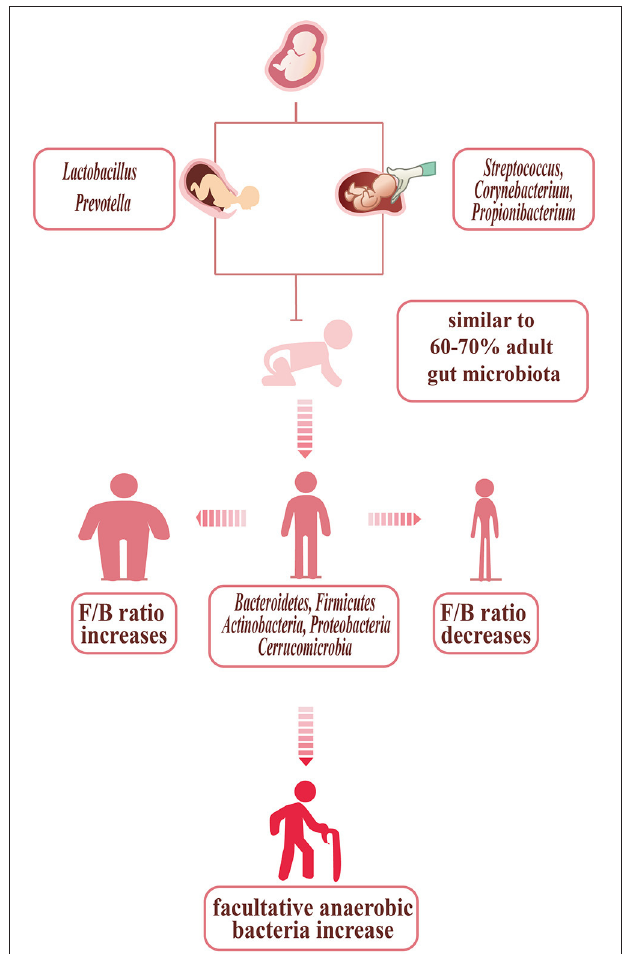
FIGURE 1 | Bacterial changes with age, delivery mode, and body shape. The infants’, born through vagina, are initially colonized by vaginal microorganisms— Lactobacillus and Prevotella. The infants’, born through cesarean section, are dominated by Streptococcus , Corynebacterium , and Propionibacterium , similar to the skin of humans. In children up to 3 years old, the gut microbiota is stable, with 60–70% similarity to the adult gut microbiota. The gut microbiota of adult with normal shape is mainly composed of five phyla: Bacteroidetes , Firmicutes , Actinobacteria , Proteobacteria , and Cerrucomicrobia . The adults who are so slim are prone to show the F/B ratio increasing, while the F/B ratio of the obese decreasing. The gut microbiota of the elder changed: the diversity decreasing, with facultative anaerobic bacteria